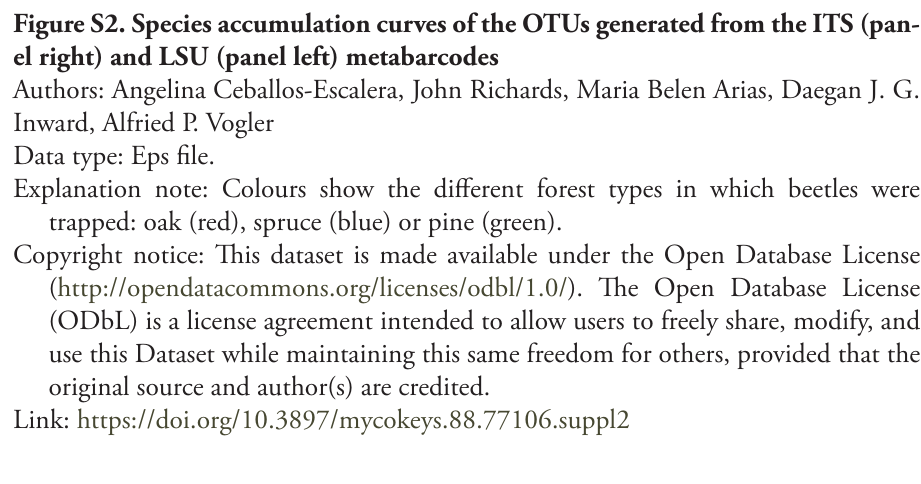
Figure S2. Species accumulation curves of the OTUs generated from the ITS (pan- el right) and LSU (panel left) metabarcodes Authors: Angelina Ceballos-Escalera, John Richards, Maria Belen Arias, Daegan J. G. Inward, Alfried P.